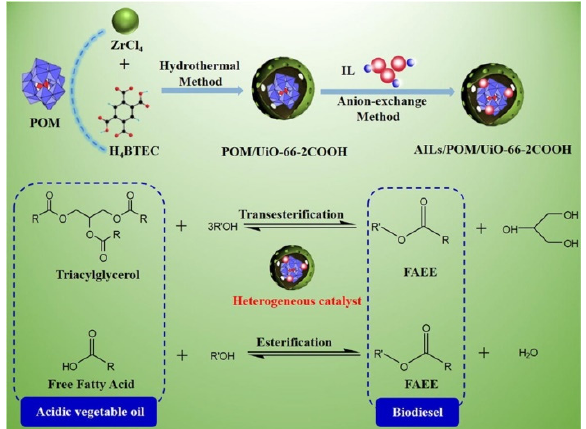
Figure 9. ( A ) Synthesis procedure of the AILs/HPW/UiO-66-2COOH catalyst, and ( B ) one-pot transesterification-esterification of acidic vegetable oils. Reprinted from [114]. Copyright (2019), with permission from Elsevier.